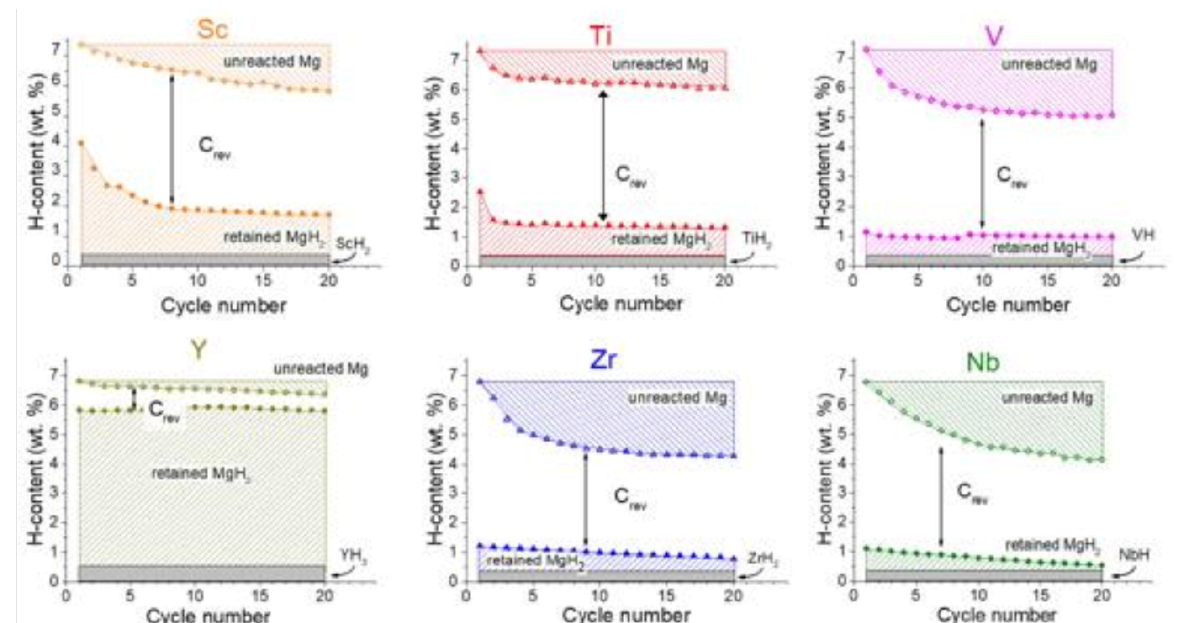
Figure 32. H content in MgH 2 –ETMH x nanocomposites for subsequent desorption (full symbols) and absorption (empty symbols) sweeps. Hatched areas stand for retained MgH 2 and unreacted Mg at each sorption sweep, respectively. The irreversible hydrogen content stored in the form of thermodynamically stable ETMH x is displayed in grey at the bottom. The white area located between the upper and lower hatched ones gives the reversible capacity C rev . Reproduced